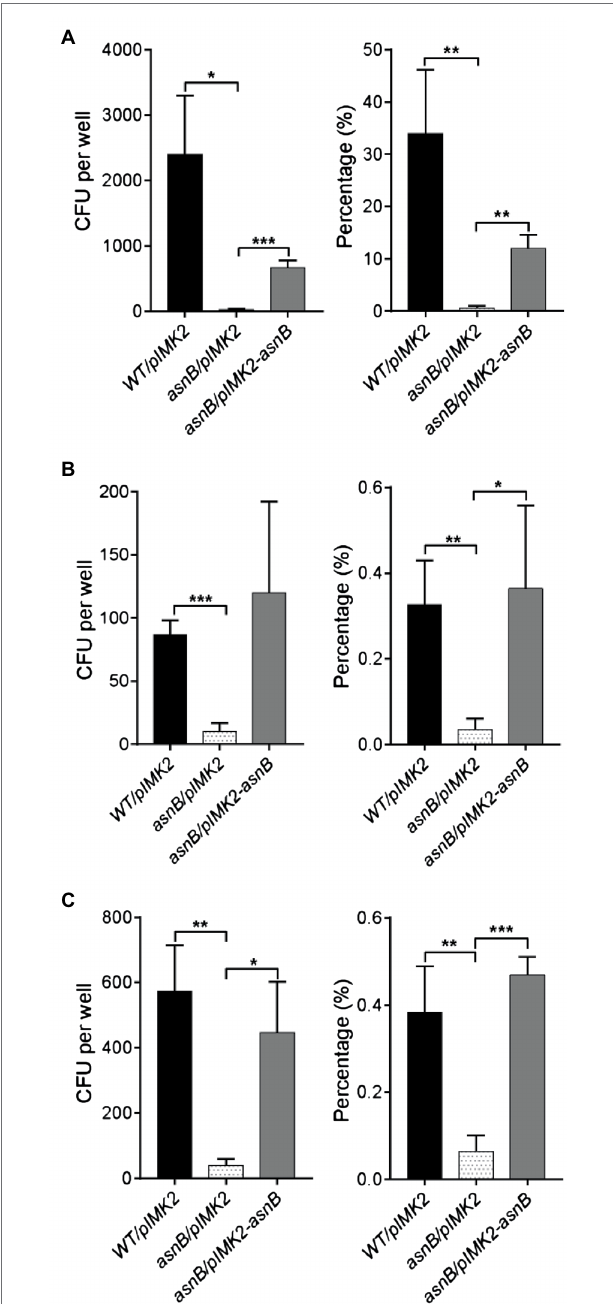
FIGURE 7 | Analysis of cell invasion by the L. monocytogenes asnB mutant using gentamicin invasion assays. The number of intracellular bacteria was enumerated by CFU counts (left panel) and the invasion efficiency was expressed as the percentage of intracellular bacteria relative to the bacterial inoculum (right panel). (A) Human JEG-3 placental cells were infected with WT/pIMK2 , asnB/pIMK2 , or asnB/pIMK2-asnB bacteria for 4 h (1 h to allow bacterial entry and 3 h of treatment with gentamicin, which kills extracellular bacteria). (B,C) Human Caco-2 intestinal cells were infected with WT/pIMK2 , asnB/pIMK2 , or asnB/pIMK2-asnB bacteria at either exponential (B) or stationary (C) phase for 1 h (0.5 h to allow bacterial entry and 0.5 h of treatment with gentamicin). All data represent mean ± SD; n = 3; *, p < 0.05; **, p < 0.01; ***, and p < 0.001 by two-tailed student’s t